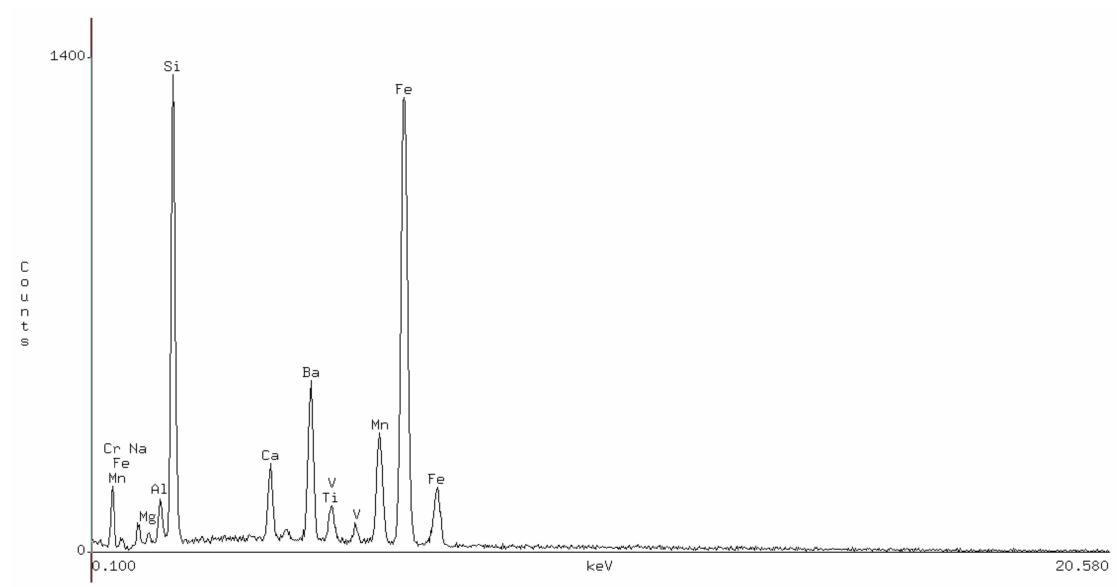
Figure 9. The infrared powder spectrum curve of modified infrared powder